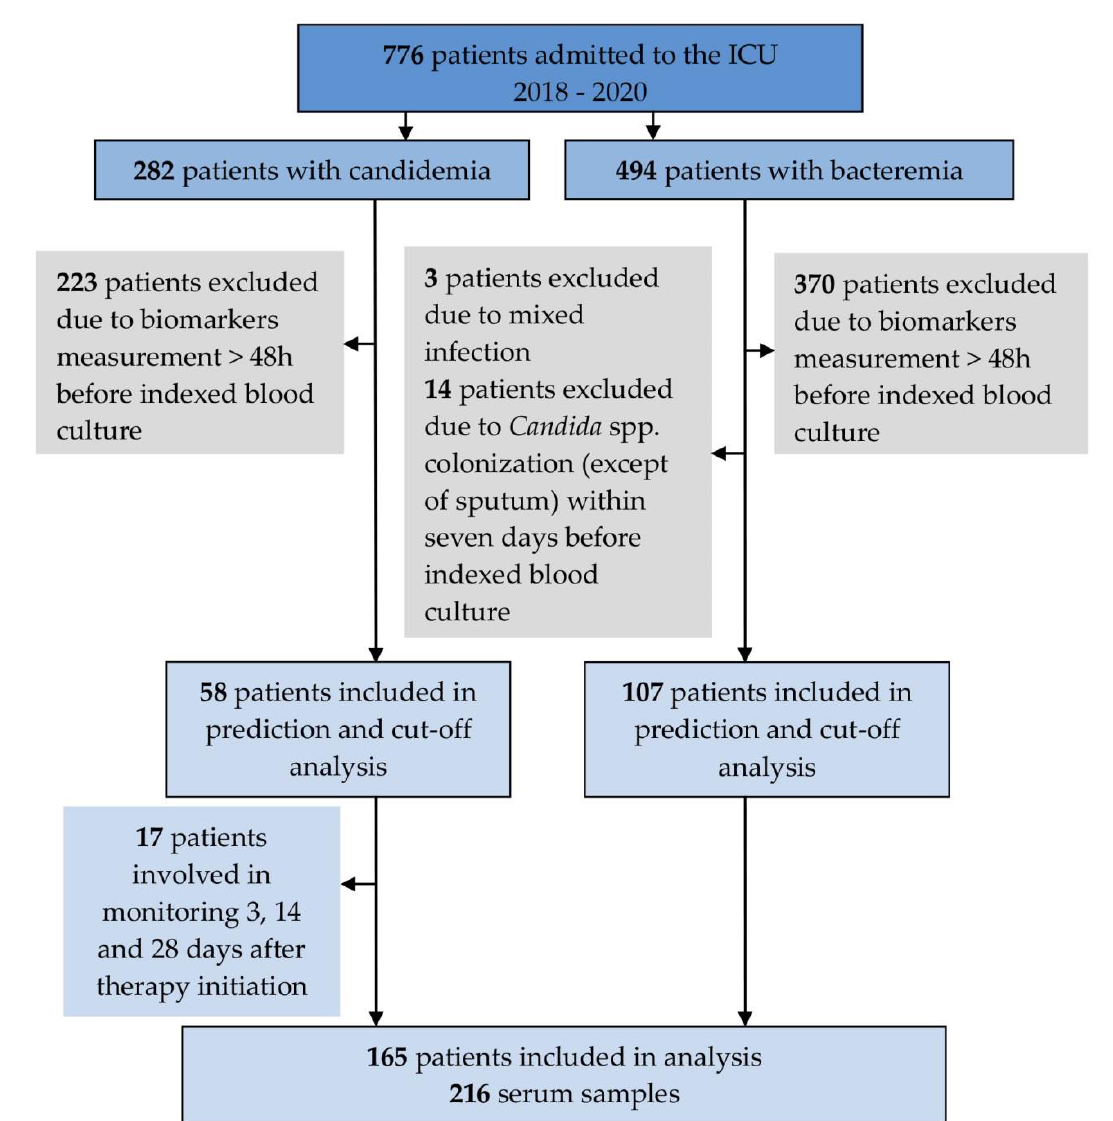
Figure 1. Flowchart showing the process used to select patients for inclusion in the analysis.